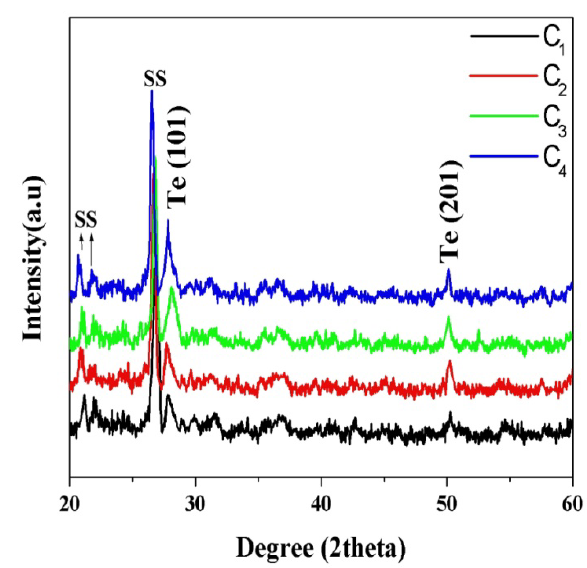
Fig. 2. XRD patterns of tellurium films with different thicknesses. Table 2. Grain size of tellurium films with different thicknesses.